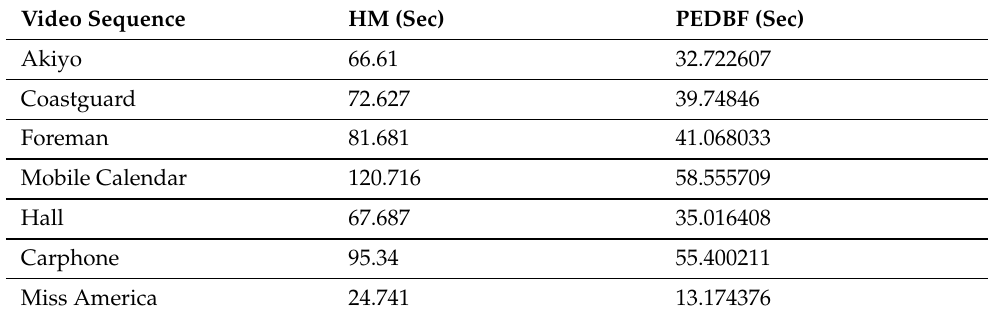
Table 11. Processing time of QCIF video sequences with QP = 27.